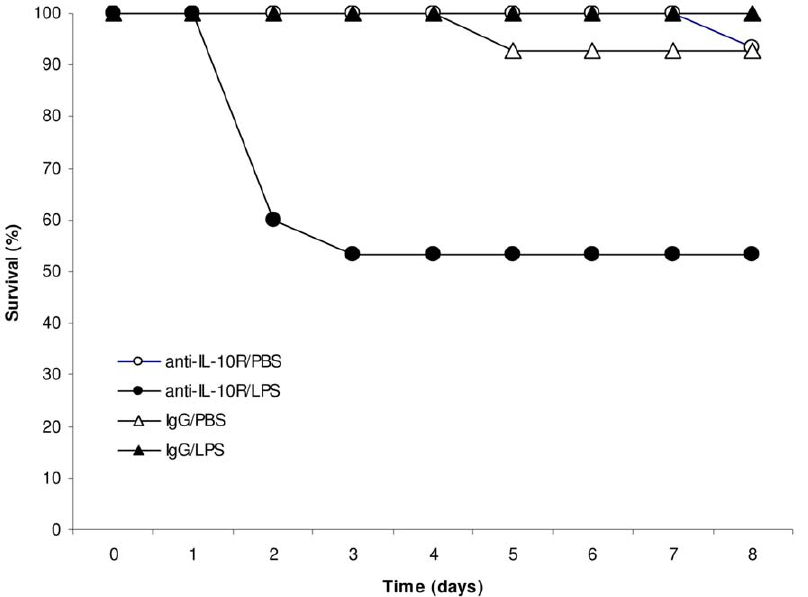
Figure 1. Survival rate of 15 month old mice during the course of the experiment for the two treatments. Empty dots: anti-IL-10R/PBS; full dots: anti-IL-10R/LPS; empty triangles: IgG/PBS; full triangles: IgG/LPS. None of the 3 month old mice died during the course of the experiment.